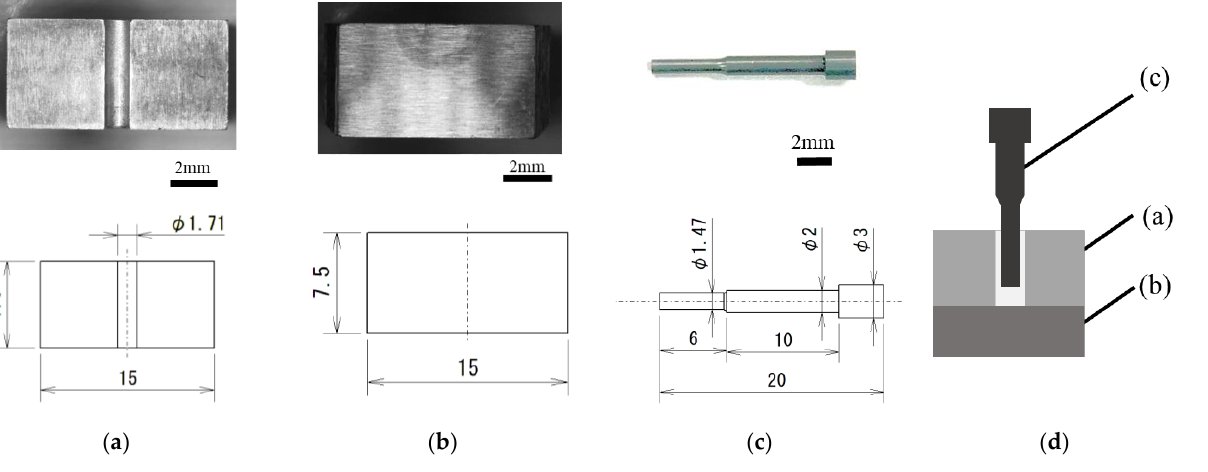
Figure 2. Shape of the die and punch: ( a ) extrusion die, ( b ) jig, and ( c ) punch; ( d ) schematic of backward microextrusion [21].